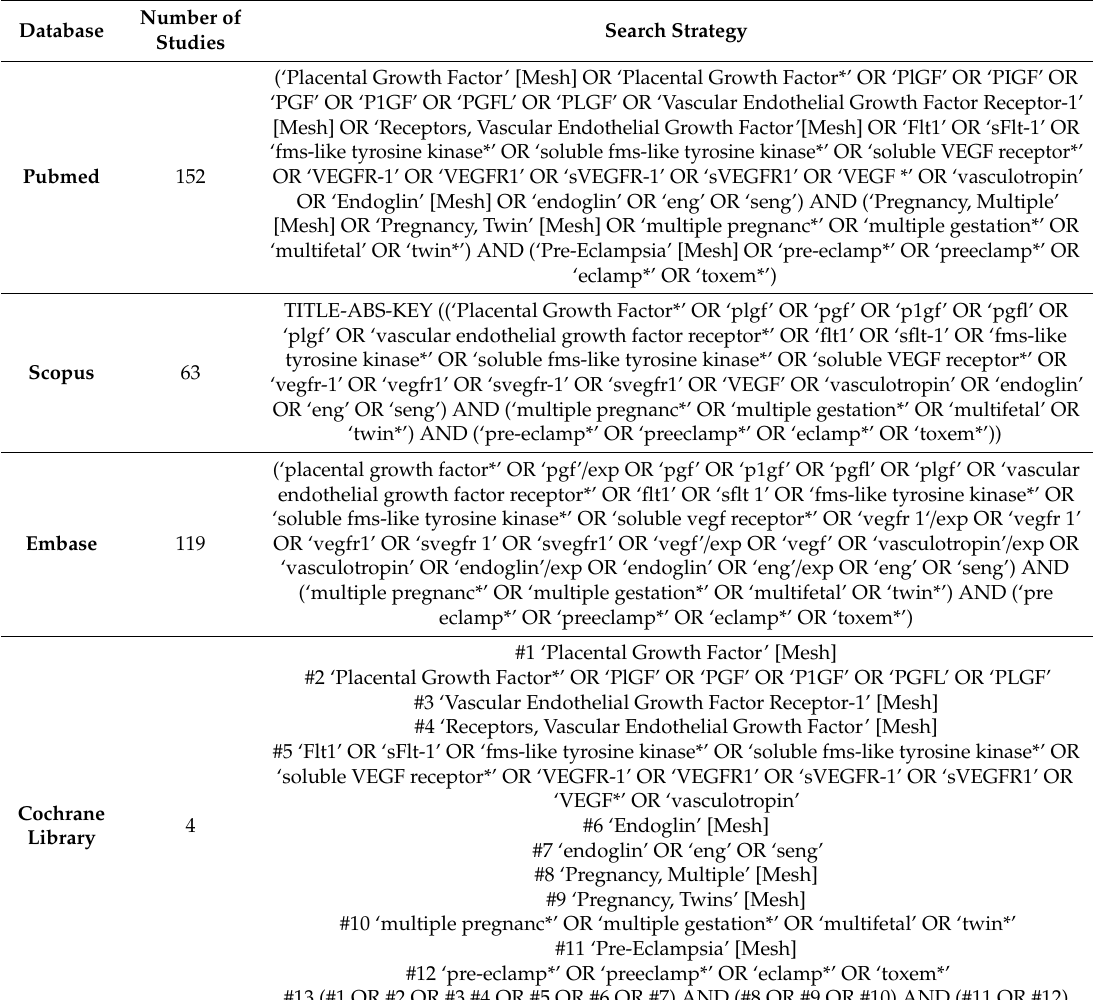
Table 1. Detailed search strategies used for